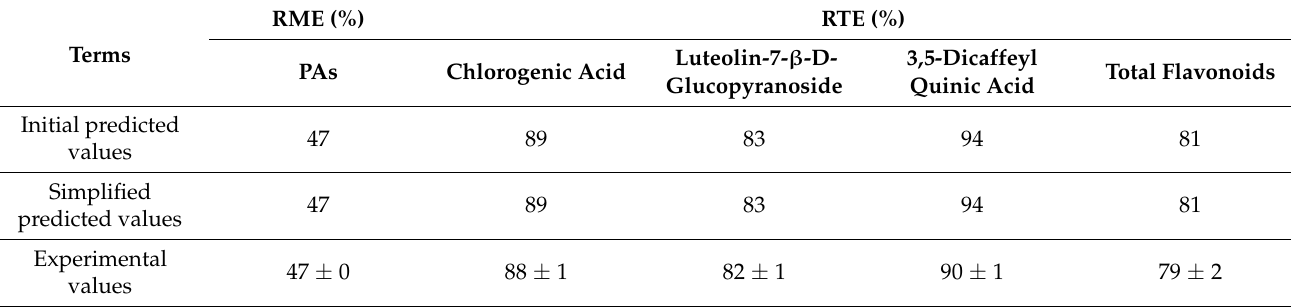
Table 4. Predicted and experimental values of dependent variables at optimum